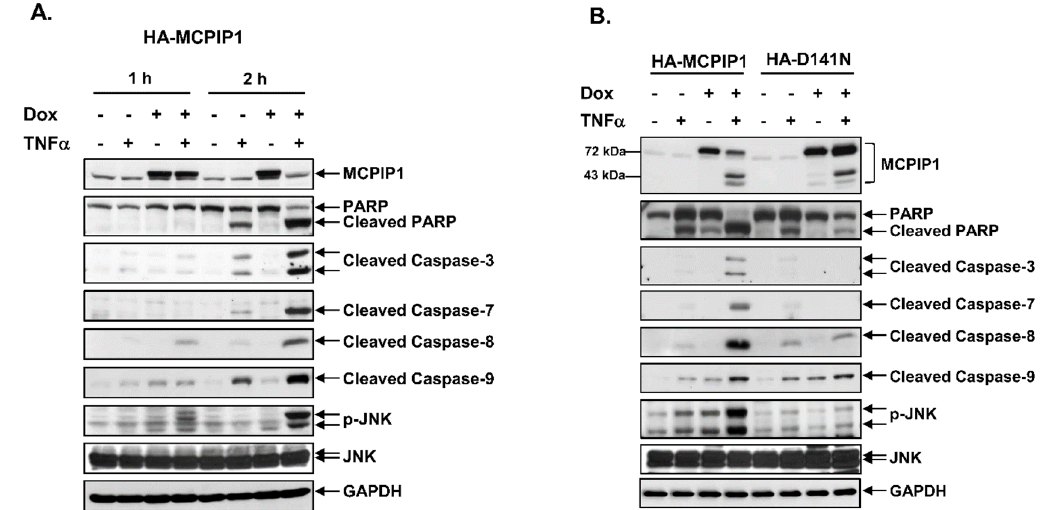
Figure 2. Overexpression of MCPIP1 enhanced TNF- α -activated caspases and JNK. ( A ) T-REx-293 cells with wild-type hemagglutinin (HA)-MCPIP1 were pretreated without or with 1 μ g/mL of doxycycline (Dox) for 16 h, and then treated with or without 10 ng/mL TNF- α for 1 and 2 h. ( B ) T-REx-293 cells with wild-type HA-MCPIP1 or the HA-MCPIP1-D141N mutant (HA-D141N) were pretreated without or with 1 μ g/mL of Dox for 16 h, and then treated with or without 10 ng/mL TNF- α for 2 h. Total cell lysates were collected, and protein expressions were determined by Western blotting.